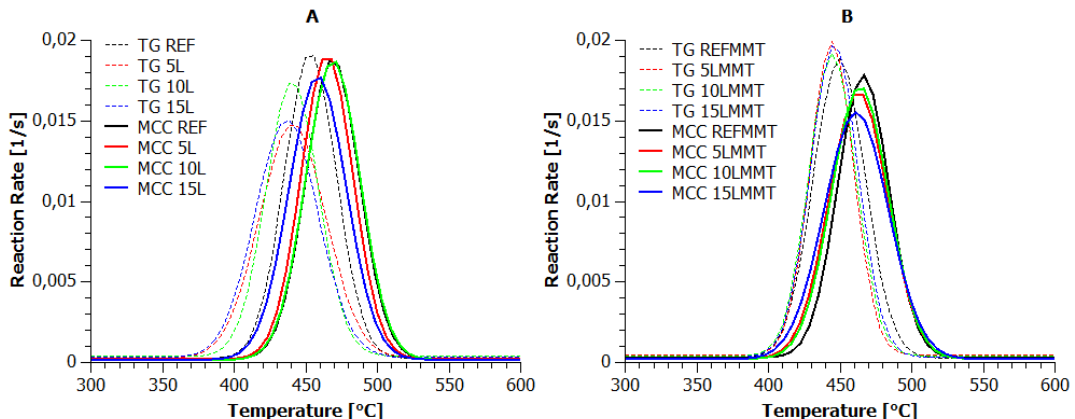
Figure 7. Comparison of the thermogravimetry (TG) and microscale combustion calorimetry (MCC) measurements by determining the reaction rates detected by TG and MCC as a function of temperature during the thermal decomposition of the PA6 samples (heating rate 1 ◦ C / min): ( A ) the samples without nanofiller; and ( B ) the samples with nanofiller.